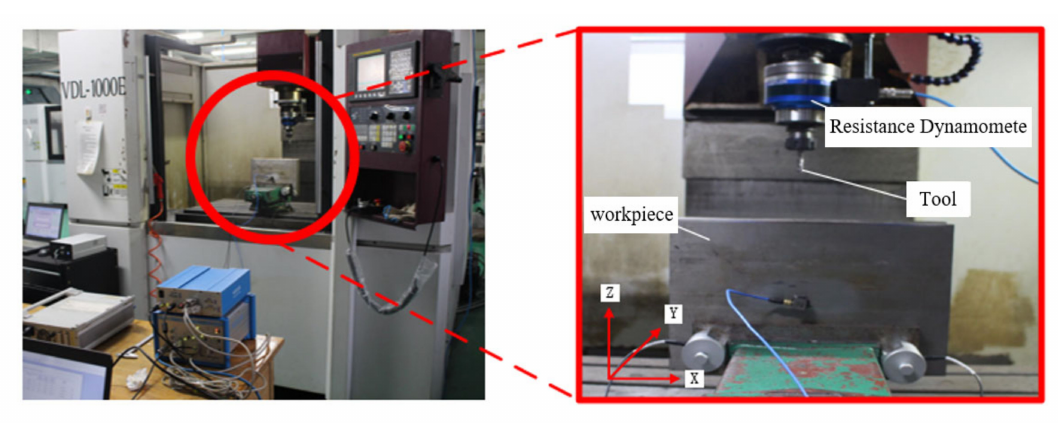
Figure 9. Milling processing test site.